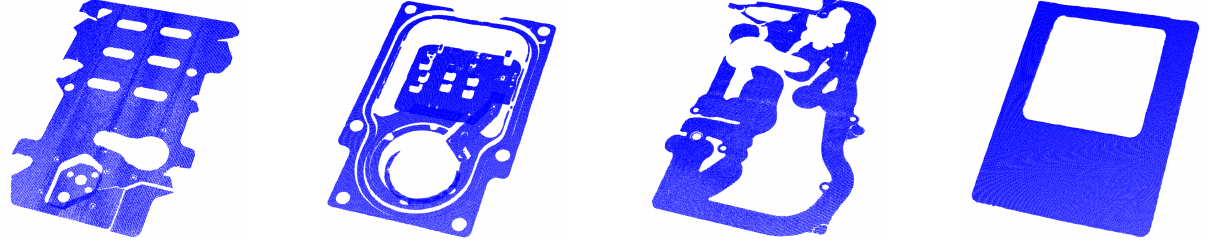
Figure 6. Display of point clouds for registration with different parameters, the point clouds and their average resolutions from left to right are M 1 : γ 1 = 0.2782, M 2 : γ 2 = 0.0815, M 3 : γ 3 = 0.2496, and M 4 : γ 4 = 0.0754,